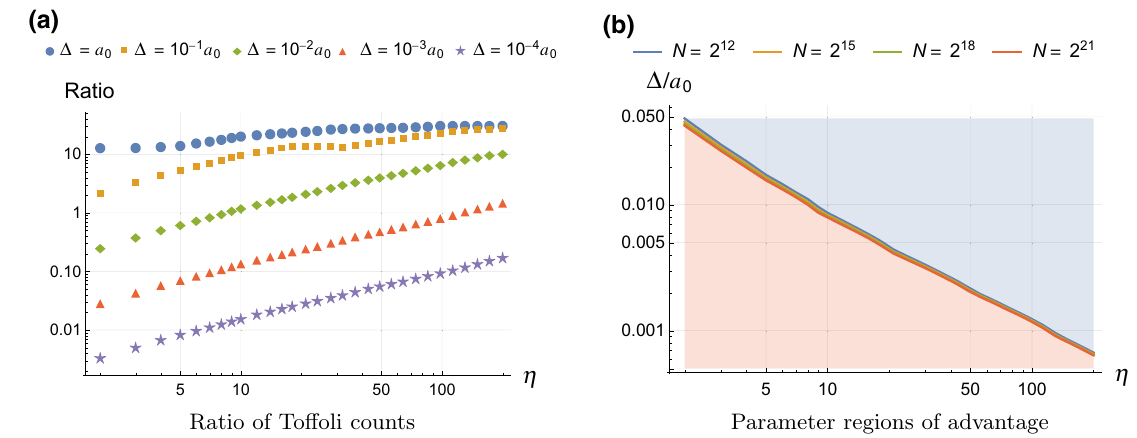
FIG. 2. (a) The ratio of the number of Toffolis for the interaction-picture approach to the number of Toffolis for the qubitization approach. We take (cid:9) = 0.0016 Hartree (corresponding to “chemical accuracy”) and N = 2 18 ≈ 2.6 × 10 5 . We again note that outside of the dependence on (cid:19) , algorithm costs depend only logarithmically on N . For simplicity these plots correspond to the uniform electron gas (i.e., U = 0) but block encoding the external potential adds only marginal overhead so we expect these costs to be broadly representative of the resources required to simulate arbitrary molecular systems as a function of η and (cid:19) . (b) The parameter region of (cid:19) versus η where there is an advantage for the Toffoli complexity for the interaction-picture approach versus qubitization. The region where the interaction picture has the advantage is shown in red, and the region where qubitization has the advantage is shown in blue. That is, the lower left of (b) is showing the values of (cid:19) for which the cost ratio plotted in (a) is less than one, as a function of η . In this figure we show the crossover for four different values of N , demonstrating that it barely changes as a function of N . In both figures we see that the interaction-picture approach only has an advantage for low particle numbers and/or when simulations target unusually high precision.